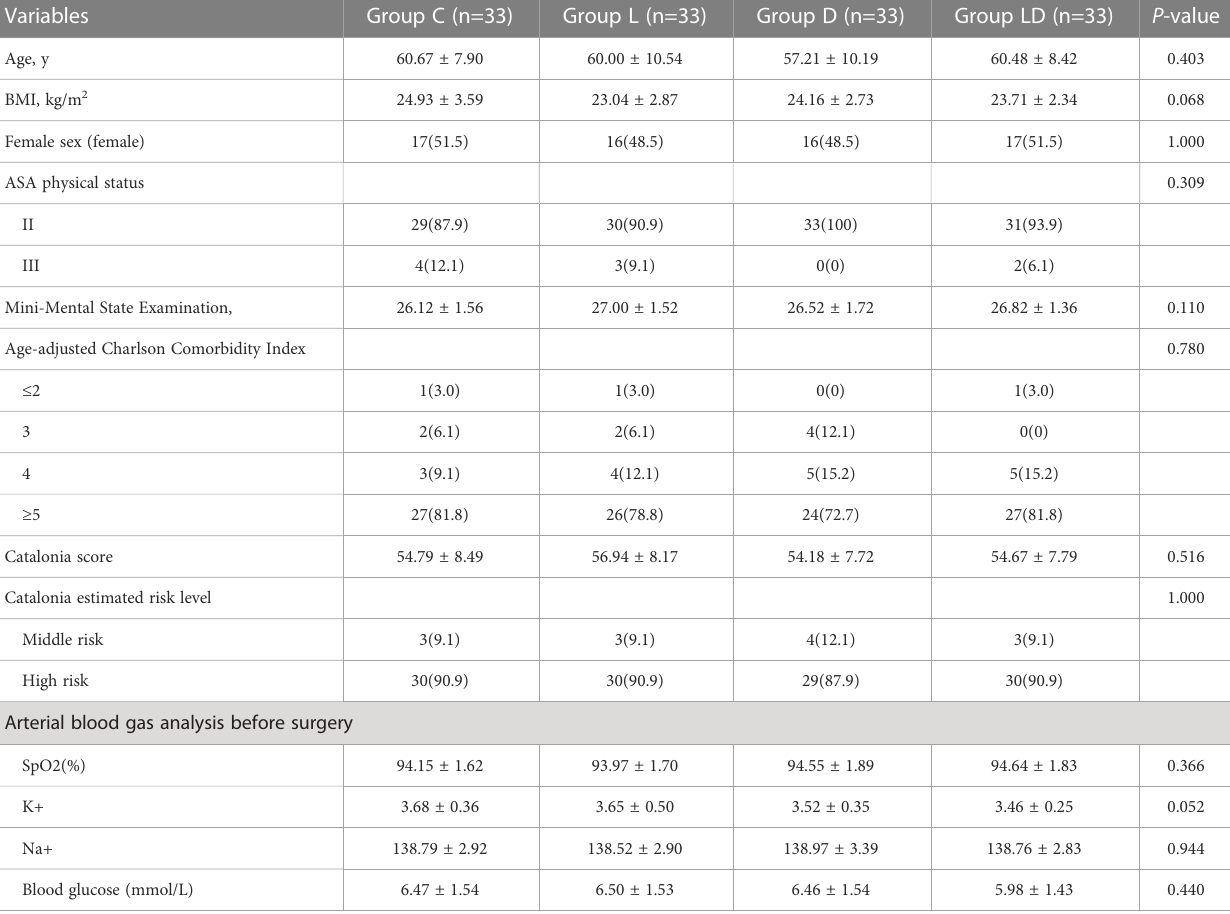
TABLE 1 Baseline demographic and clinical